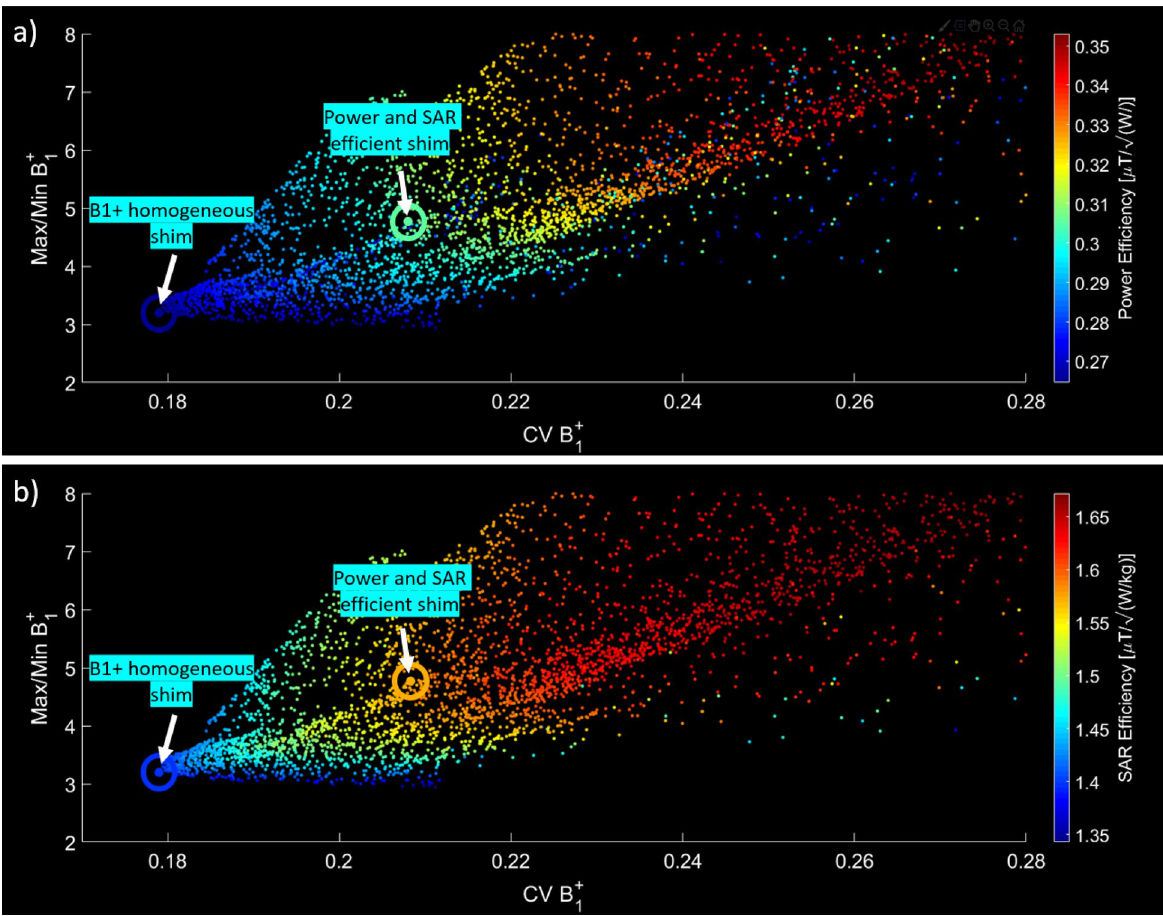
Figure 4. SAR and B 1 + phase-only RF shimming of the 16-channel Tic Tac Toe RF coil. The B 1 + homogeneity / min B parameters ( CV B and max B in X and Y axes of the plot, respectively) are compared with the power + 1 + 1 + 1 efficiency ( a ) and SAR efficiency ( b ). Each point corresponds to an RF shim case using a cost function (Eq. 1) / min B , max B , and average SAR. Average B 1 + constraints were also included. Two RF that includes CV B + 1 + 1 + 1 shim cases were chosen for experimental implementation: (1) power and SAR efficient shim and (2) B 1 + homogeneous